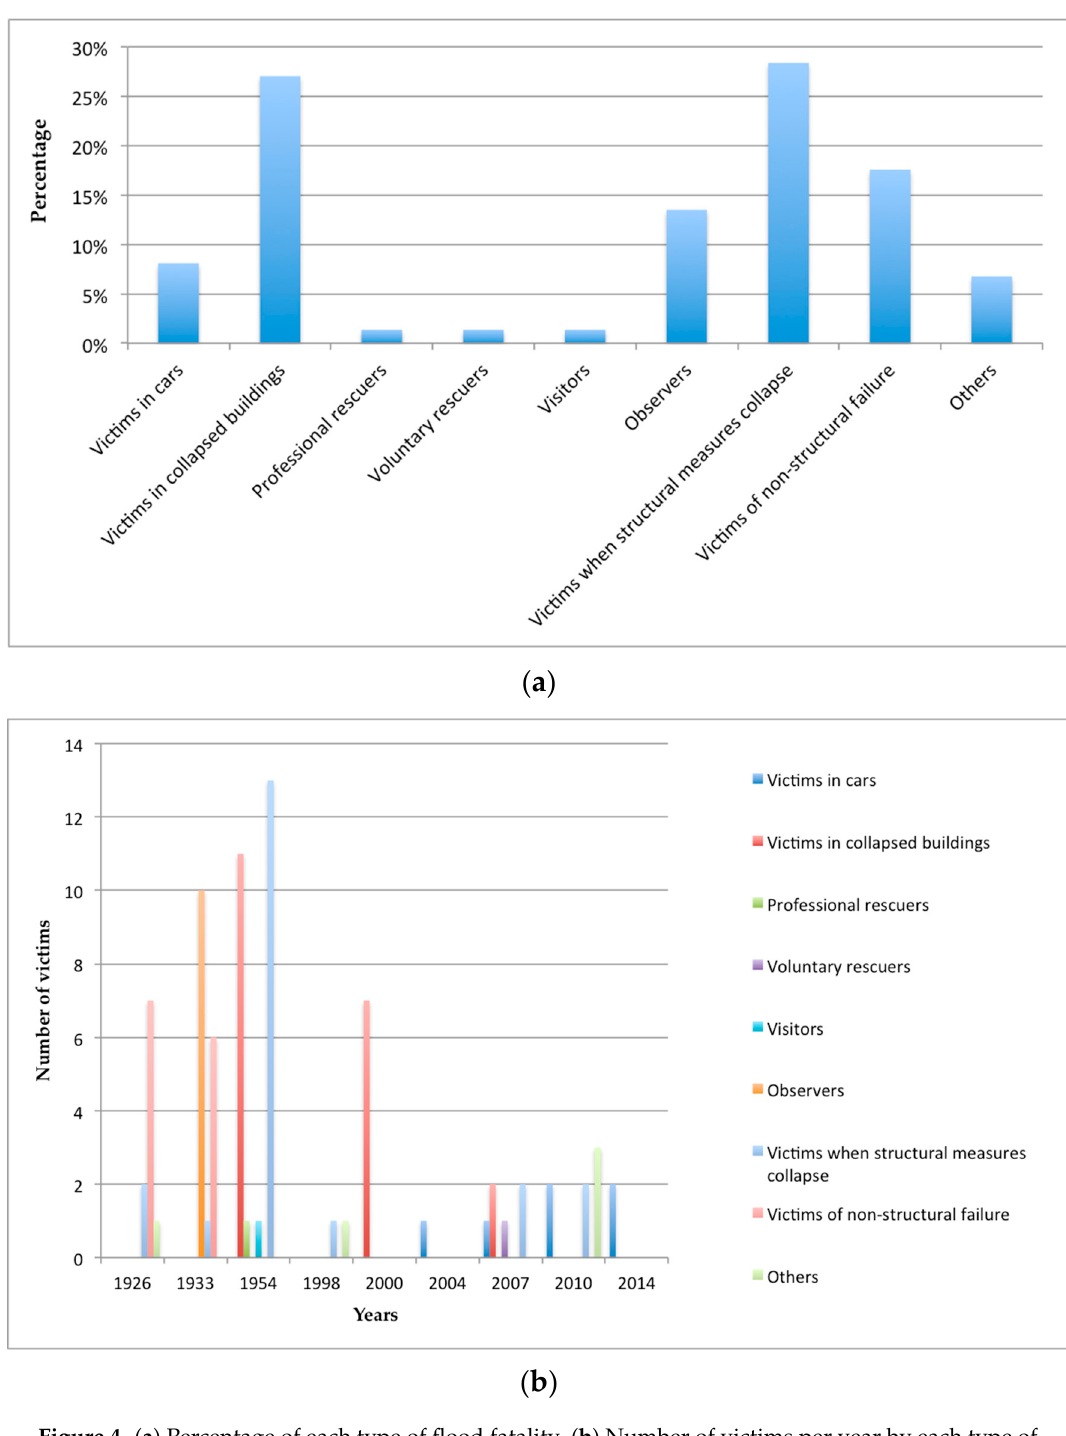
Figure 4. ( a ) Percentage of each type of flood fatality. ( b ) Number of victims per year by each type of flood fatality.